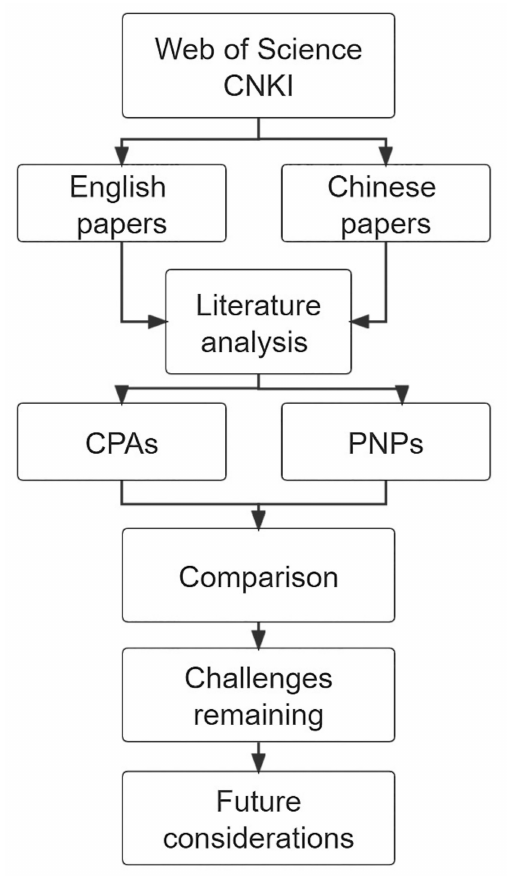
Figure 2. Methods and methodological flow. CNKI: China Integrated Knowledge, CPAs: Conven- tional protected areas, PNPs: Pilot National